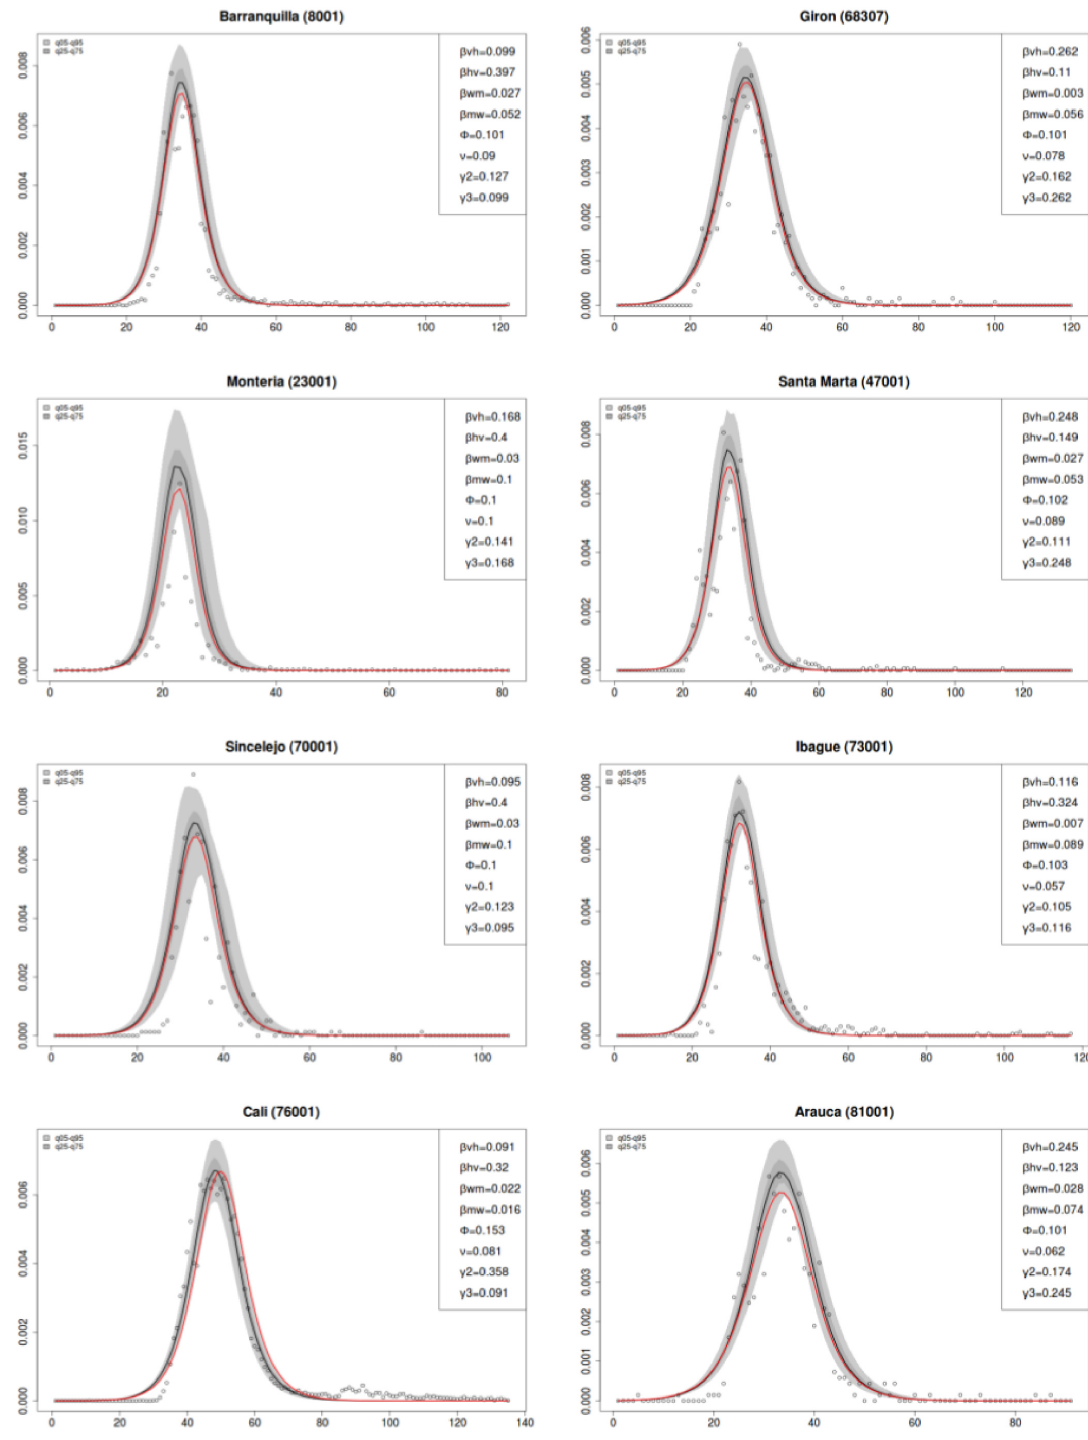
Fig 2. Comparing the adjusted proportion of observed symptomatic infections and the model output (See S1 Appendix for all plots). Y-axis is a proportion (infected / at risk population), and the x-axis is time (in weeks).